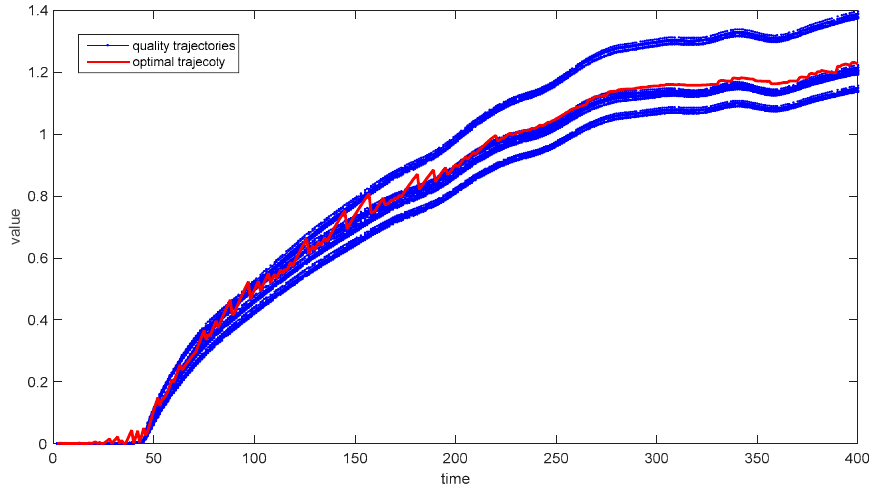
Figure 8. The solution of optimal trajectory in penicillin fermentation case.